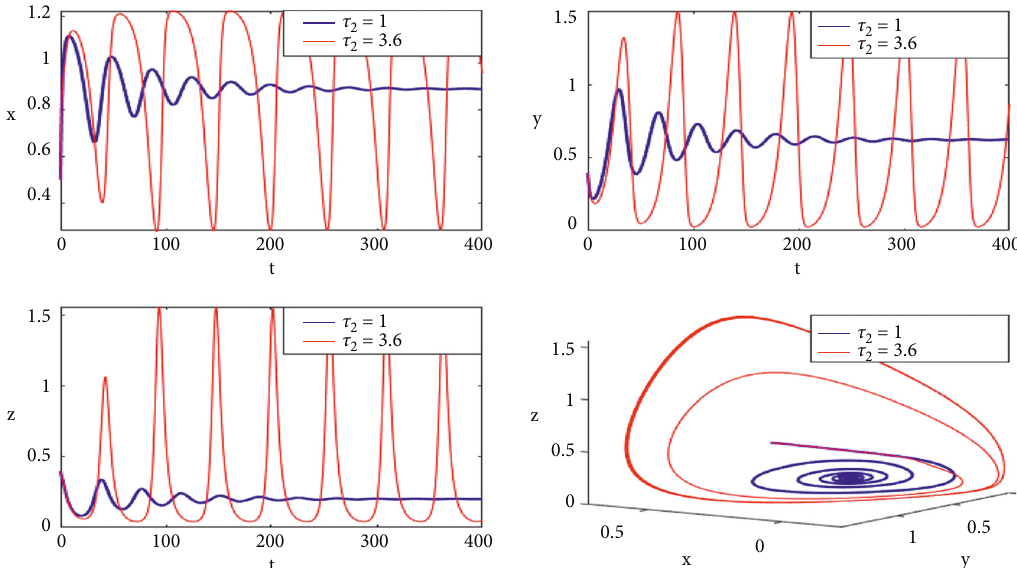
Figure 6: Case 3: the trajectories and phase diagrams of system (92) over time at τ